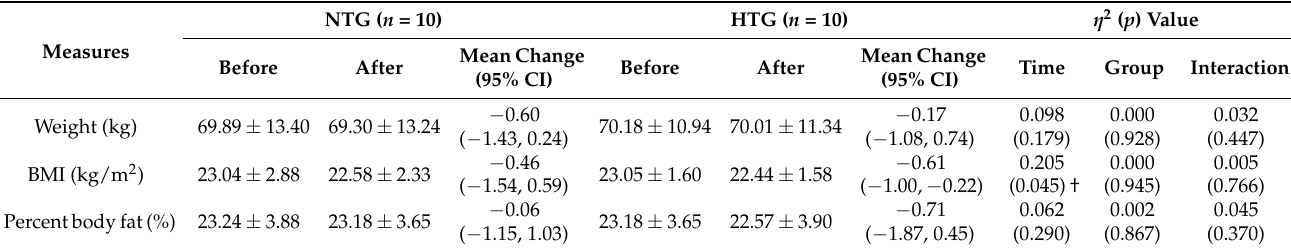
Table 2. Changes in body composition before and after training by group.